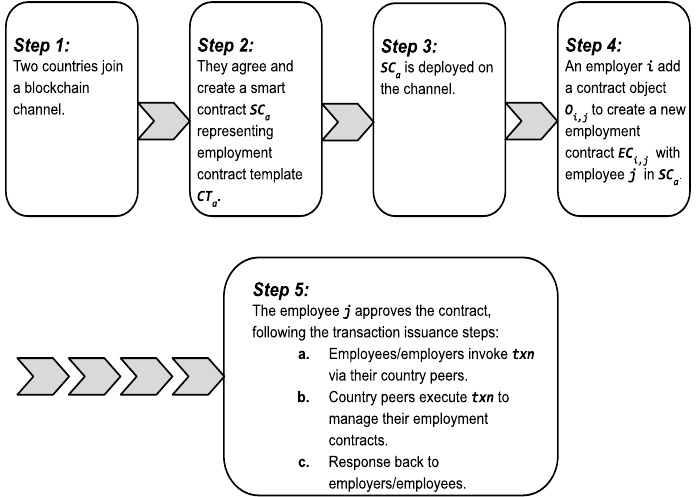
Figure 3. The workflow of managing employment